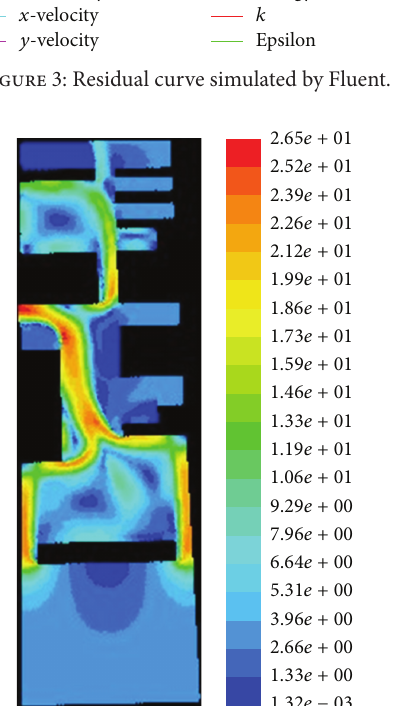
Figure 4: Profile of wind